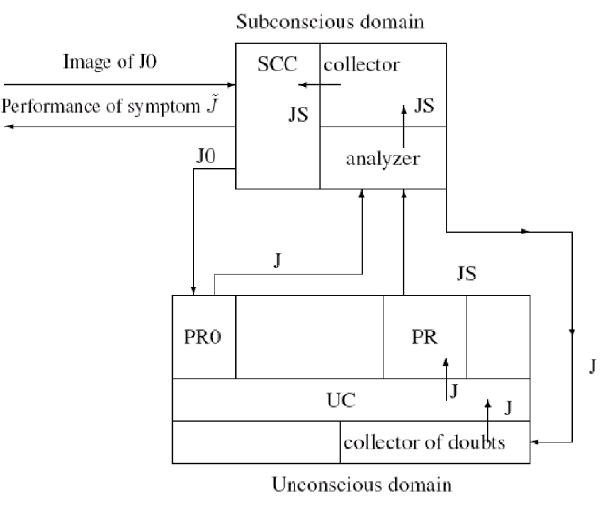
Figure 4. Symptom induced by a hidden forbidden